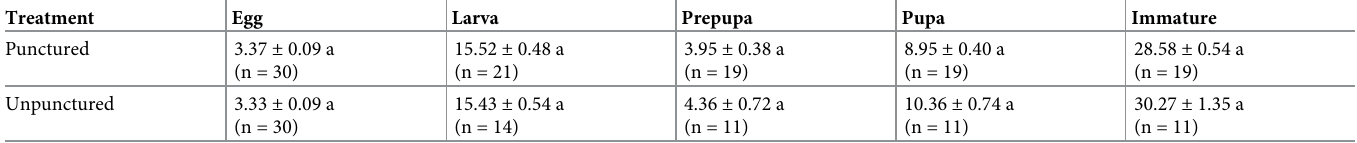
Means within a column with different letters are significantly different ( P < 0.05).